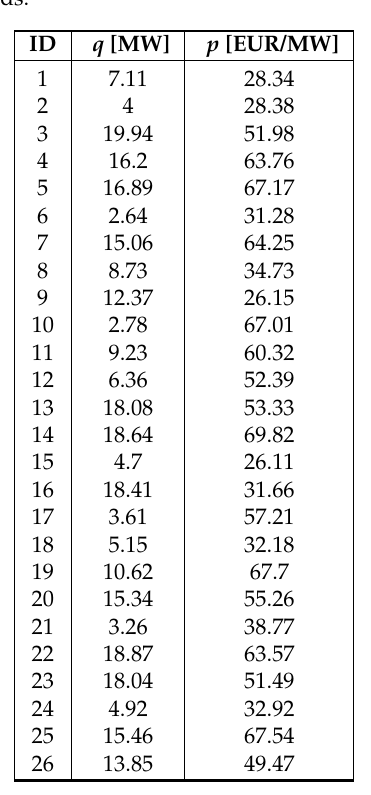
Table A4. Reference (non-SRDB) RS+ bid set: The columns correspond to the index of the bid (ID), quantity ( q ) and bid price ( p ) respectively. The SRDB bids are generated according to u , and the implied actual set of uncertain energy bids.